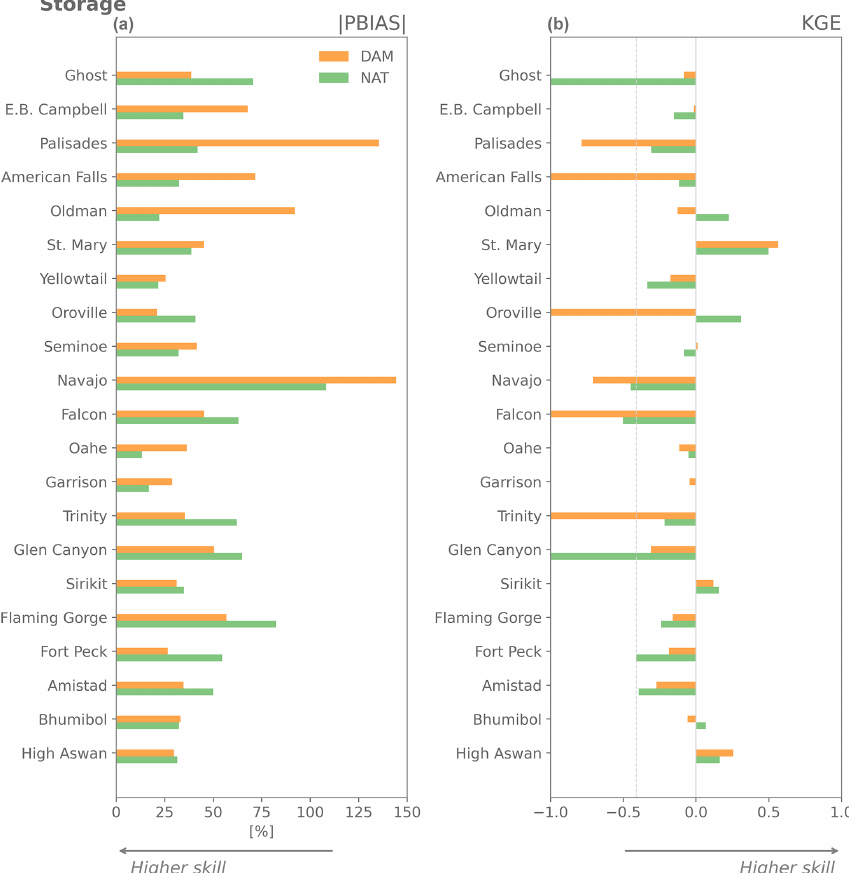
Figure 5. Performance of the global-scale mizuRoute simulations for storage compared to reservoir observations using the absolute percent bias ( | PBIAS | , a ) and Kling–Gupta efficiency (KGE, b ).